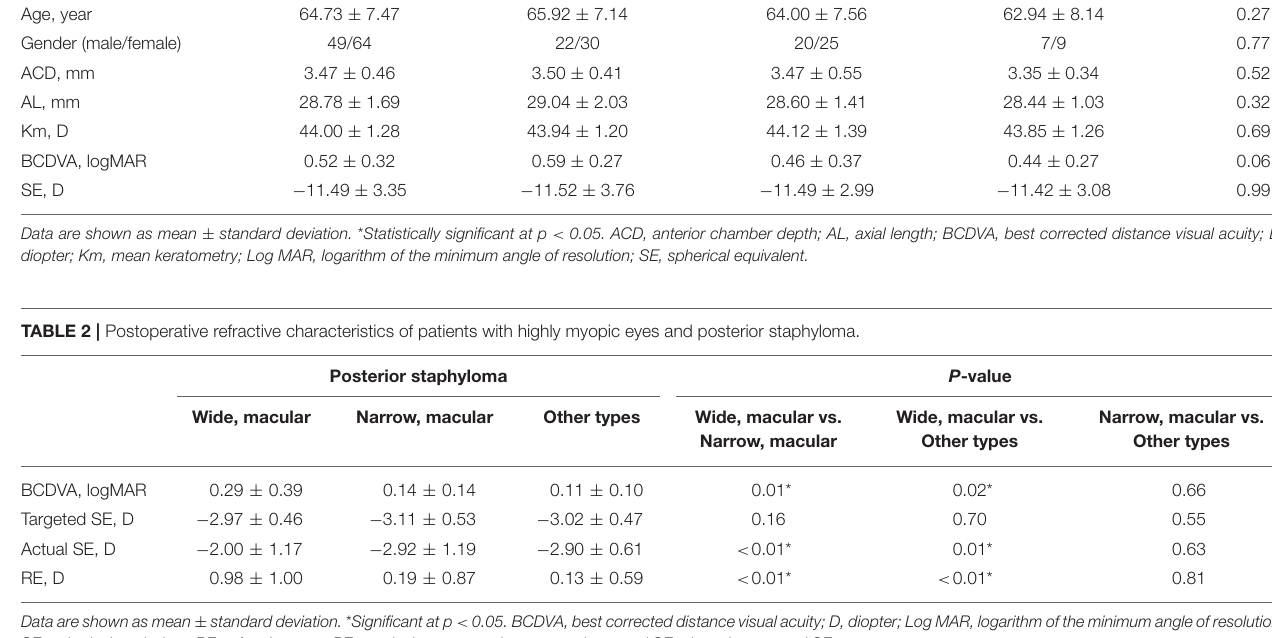
significantly correlated with postoperative refractive errors (all P >